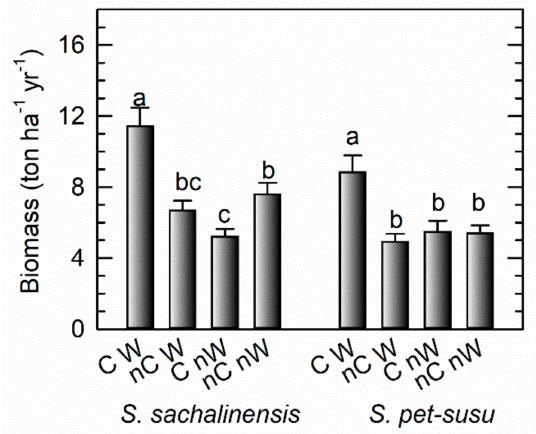
Figure 2. Comparison of dry biomass production in the first harvest cycle after three growing seasons: C and nC represent with and without cutback; W and nW represent with and without weed control, respectively. The significance values of the factorial analysis are shown in Table S1. Di ff erent letters indicate significant di ff erences in the corresponding values from the same species at p < 0.05. Values shown are mean ± SE from two clones of the same